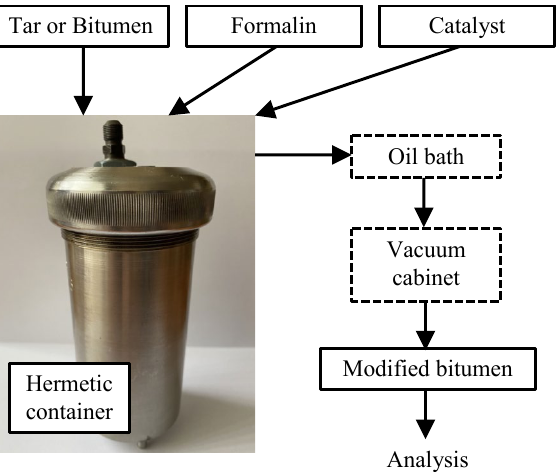
Figure 2. Scheme of the stages of work on the modification of tar and bitumen with formaldehyde.